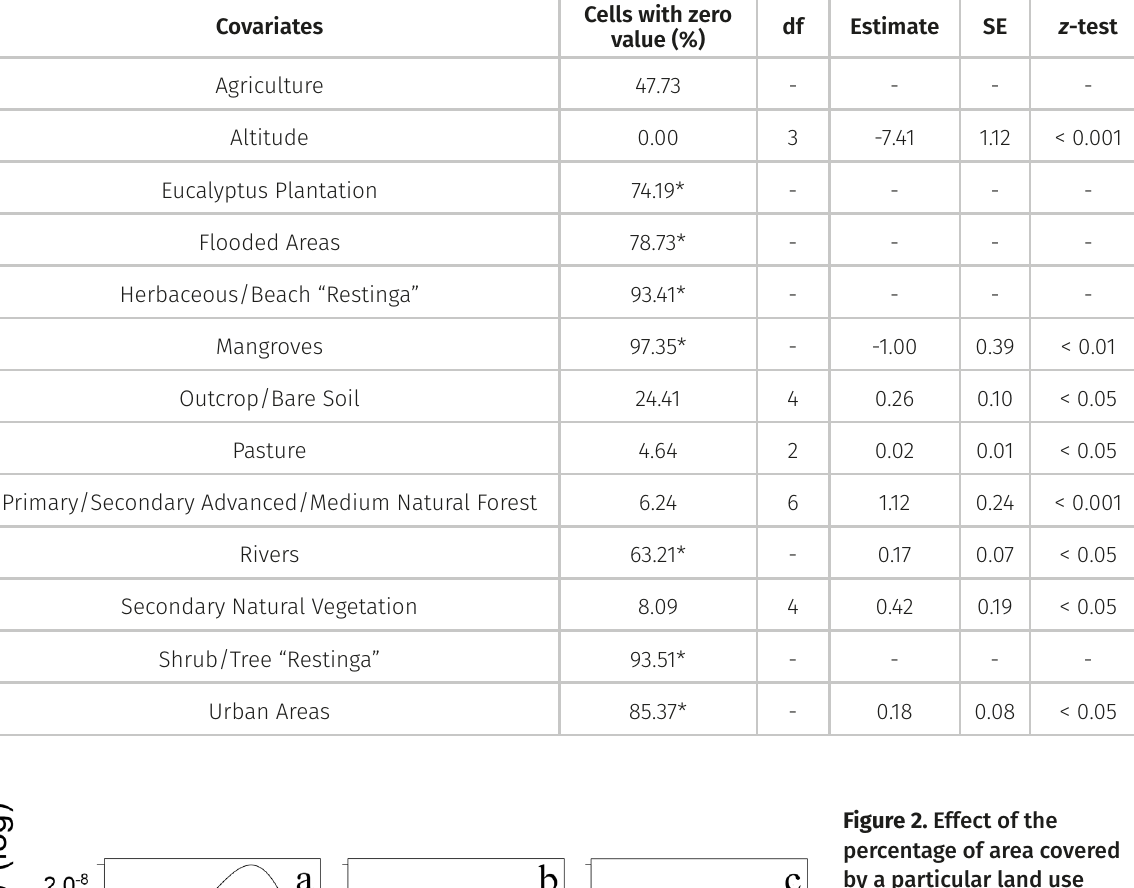
Figure 2. Effect of